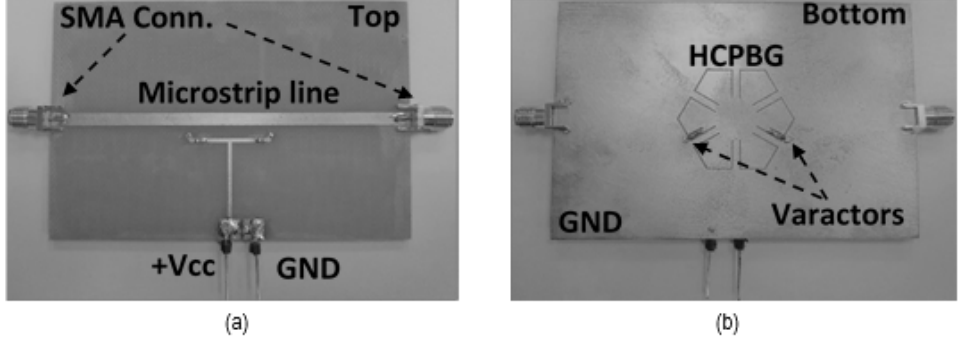
Figure 14. Reconfigurable HCPBG-6t-fabricated sample. ( a ) Top view; ( b ) bottom